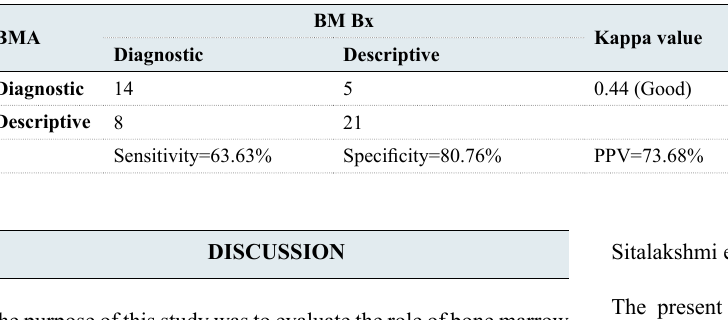
Table 4: Bone marrow aspiration versus Bone marrow trephine biopsy. BMA